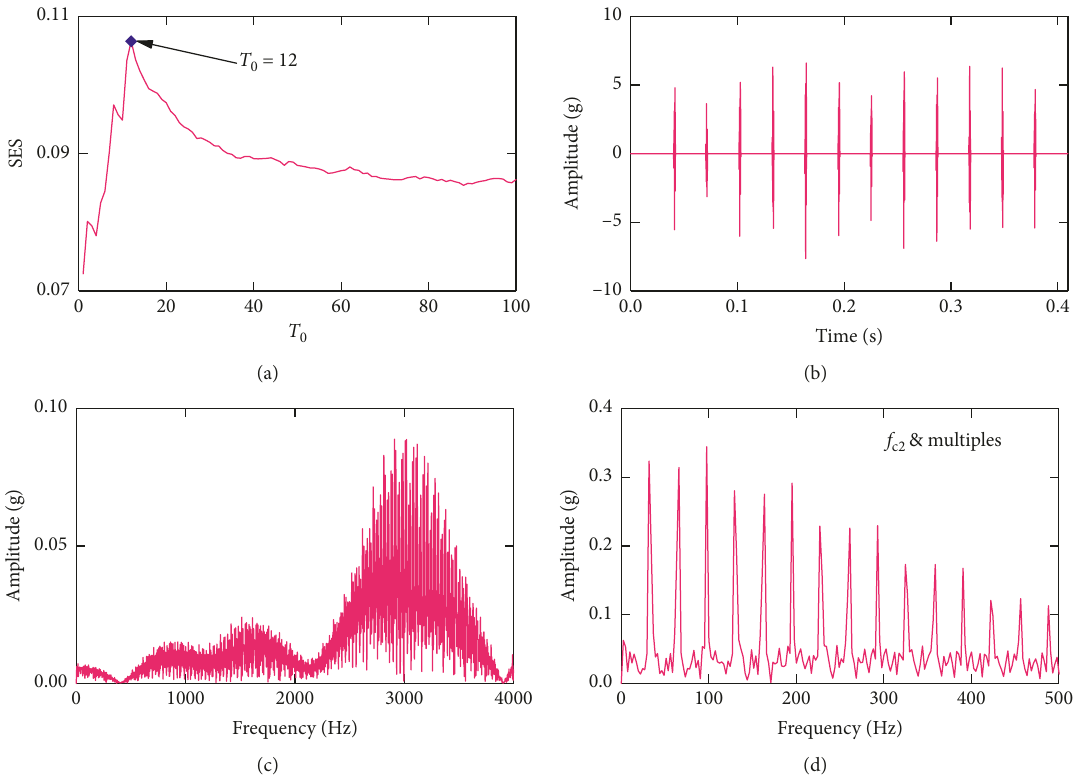
Figure 7: Separated second impulse signal 􏽢 y 2 using H-SI-K-SVD: (a) SES values for different number of iterations; (b) time-domain waveform of 􏽢 y 2; (c) Fourier spectrum of (b); (d) Hilbert envelope spectrum of